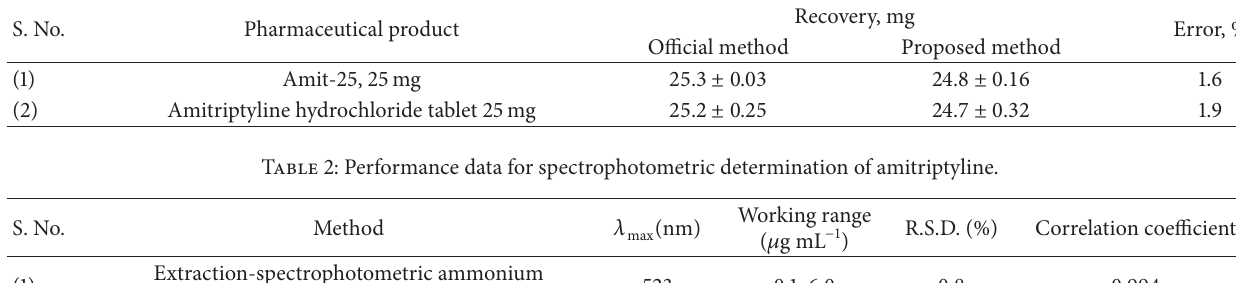
Table 1: The results of analysis of “Amitriptyline” tablets by proposed and official methods. S. No.